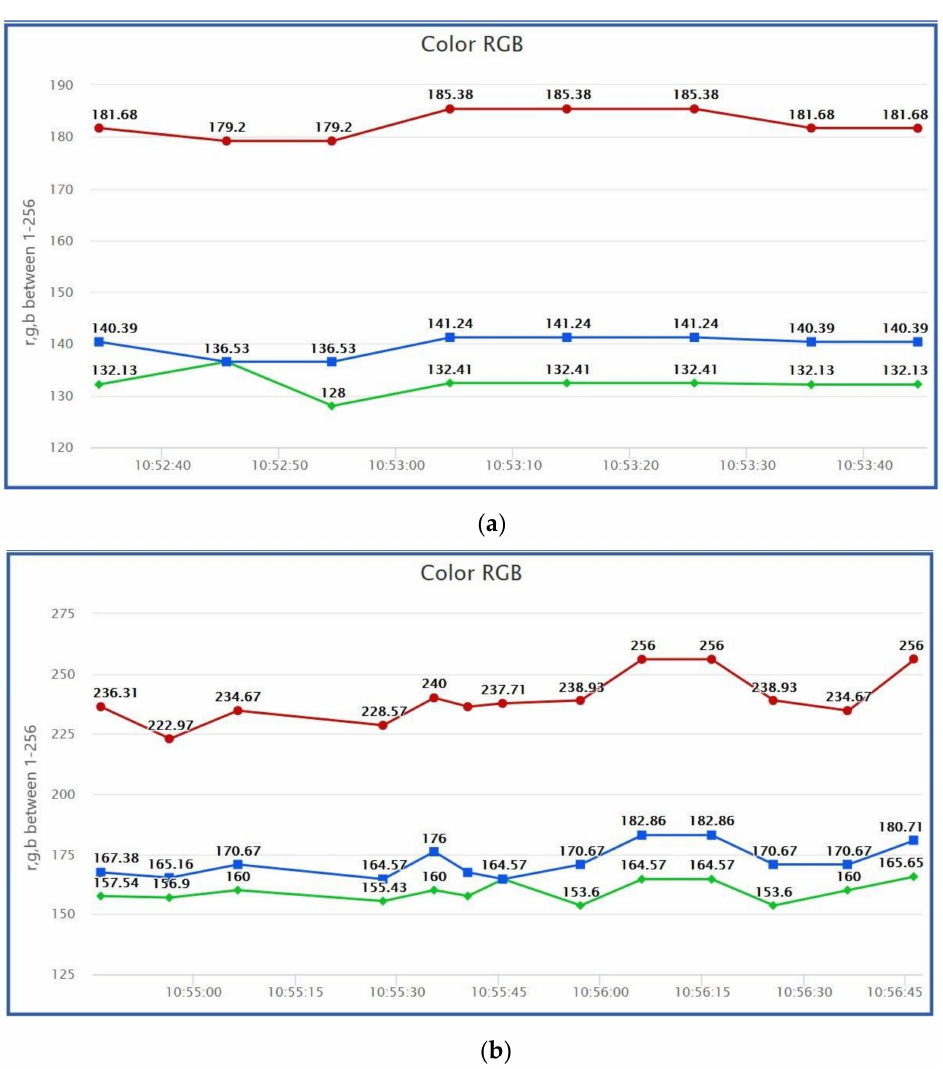
Figure 19. Color RGB sensor lectures without hematoma ( a ) and with hematoma ( b